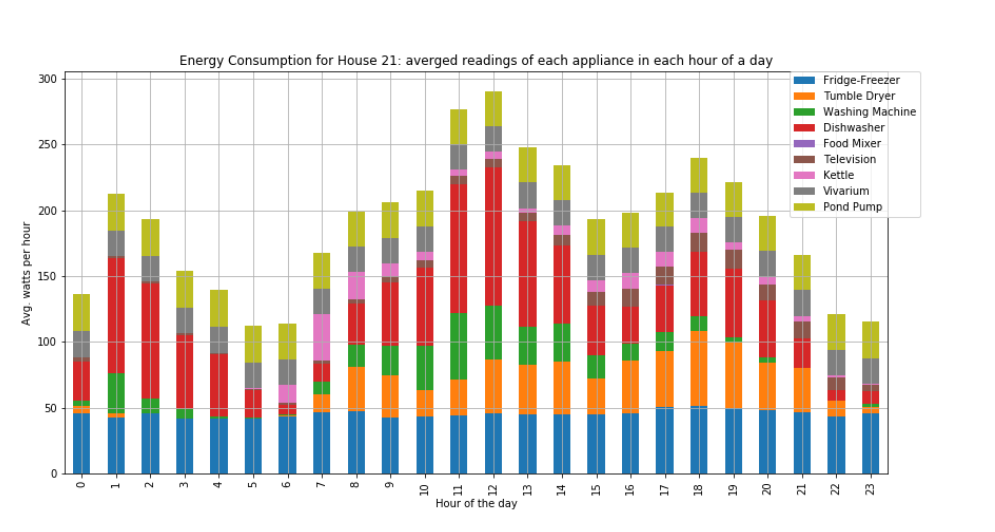
Figure A10. The average consumption per hour of home appliances for house 21 with four occupants.